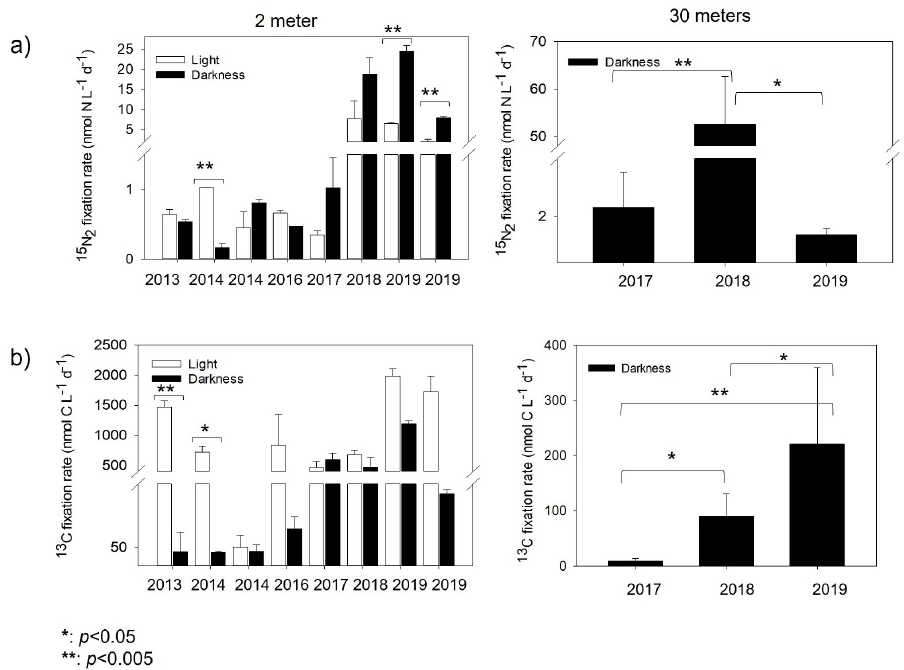
Figure 3. Interannual marine nitrogen (( a ), 15 N 2 ) fixation and carbon (( b ), 13 C) assimilation rates in Chile Bay during the late summer in 2013–2014 and 2016–2019. The white bars represent light incu- bations and black bars represent dark incubations. The error bars represent triplicate rates. Signifi- cant differences between rates ( p- value) were evaluated by the t -test. Phototrophic activity, measured in tandem with 15 N 2 fixation, showed the highest rates fluctuating between 837 and 1380 nmol C L − 1 d − 1 (Figure 3a, Table 2) for the 2 m samples (2016 to 2019) under the light condition (uncovered samples). Significant differ- ences for the years 2013 ( t -test p < 0.003) and 2014 ( t -test p < 0.01) (Figure 3b) were detected between the photosynthetic (uncovered) and chemoautotrophic (covered) 2 m samples. Chemoautotrophic carbon fixation (covered samples) for both 2 and 30 m samples was always one order of magnitude lower than under the photosynthetic condition (uncov- ered samples), in general reaching >30% contribution to the total carbon fixation. Further- more, dark rates at 30 m showed significant differences between 2017–2018 ( t -test p < 0.02), 2017–2019 ( t -test p < 0.008) and 2018–2019 ( t -test p < 0.01). Correlation analysis between N 2 and C fixation rates with the measured environmen- tal variables (temperature, Chl- a , NO 3 − , NO 2 − , NH 4+ and PO 43 − ) was conducted by linear regression. Among all the evaluated variables, the results only revealed a significant lim- iting effect for the PO 43 − concentration on both rates under contrasting light and dark in- cubations. In particular, the data showed a marked negative correlation between N 2 fixa- tion and the PO 43 − concentration, observed exclusively under the light condition (R 2 = 0.73; p = 0.007) (Figure 4a). In contrast, carbon assimilation rates showed a moderate negative